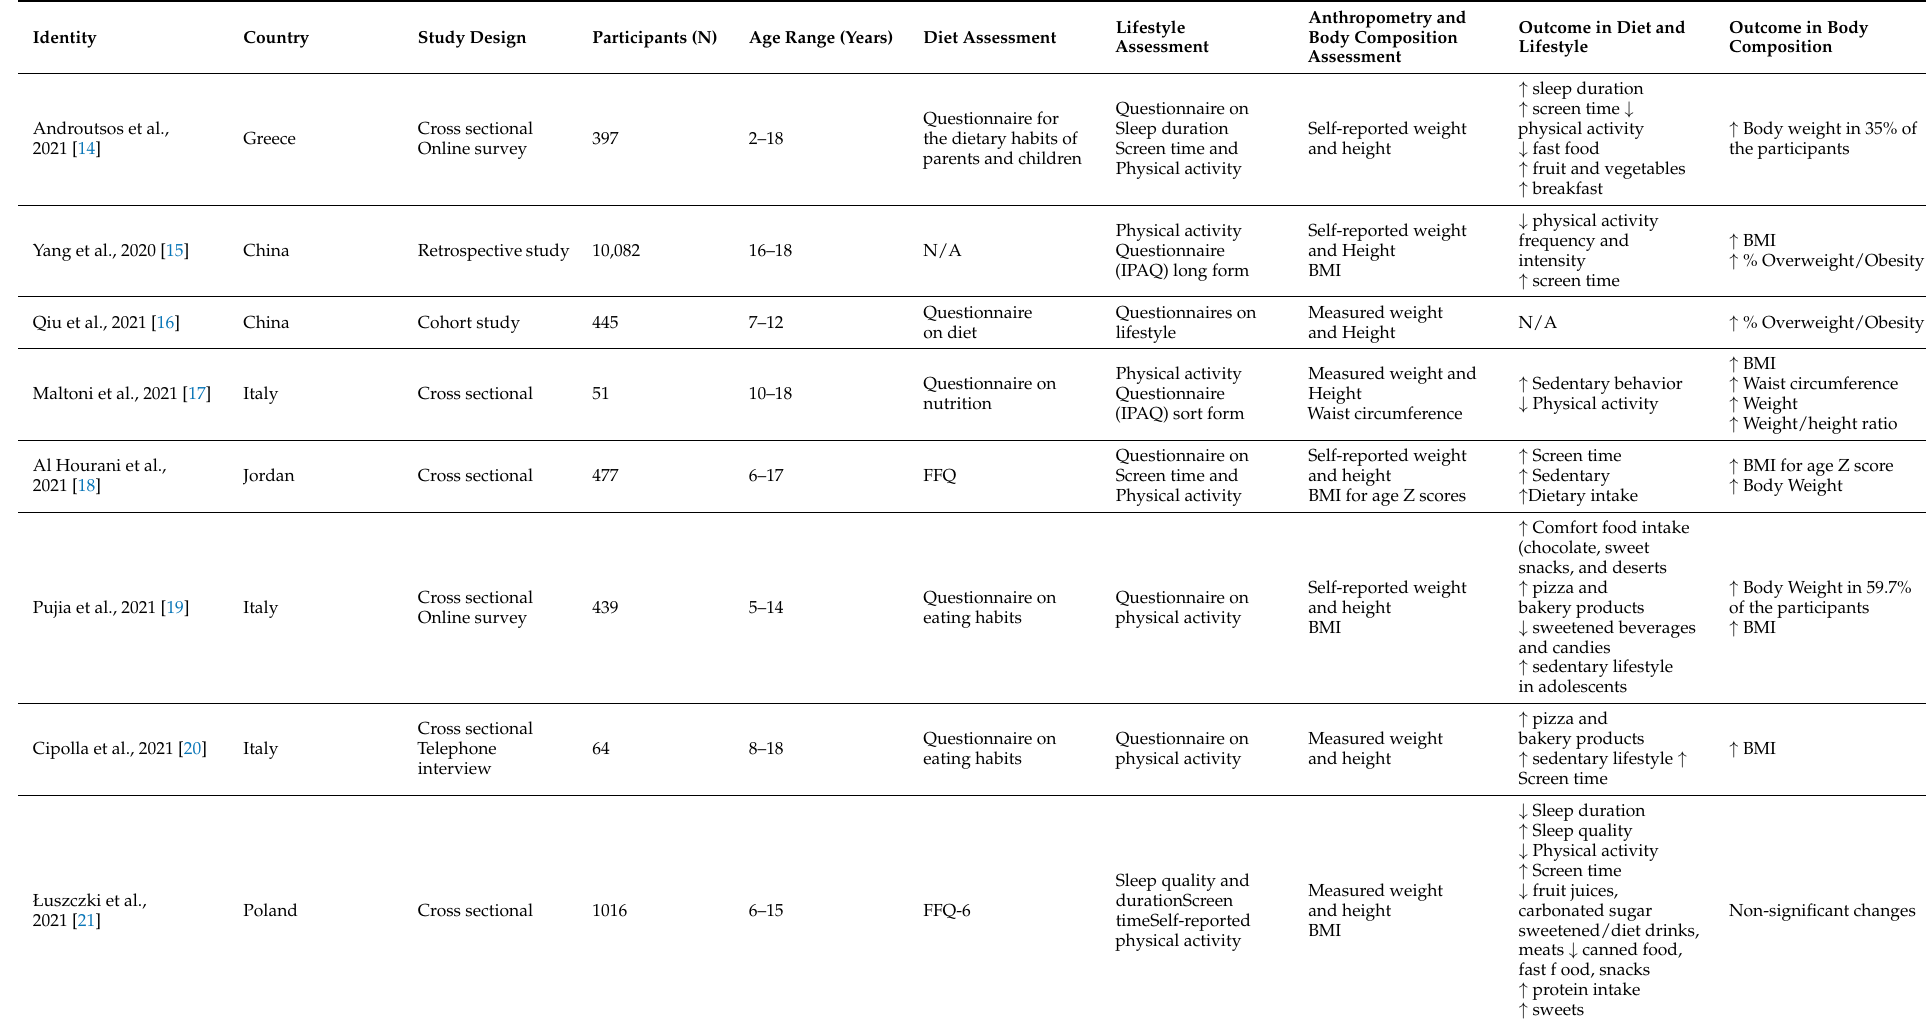
Table 1. Characteristics of studies regarding the role of diet and lifestyle changes on body weight and body